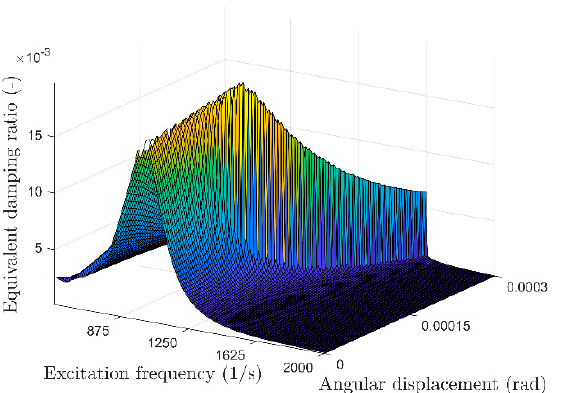
Figure 15. Adjusted three-dimensional damping diagram of a damper with a cubic nonlinear stiffness ( α = 7 · 10 11 Nm , d = 50 Nm